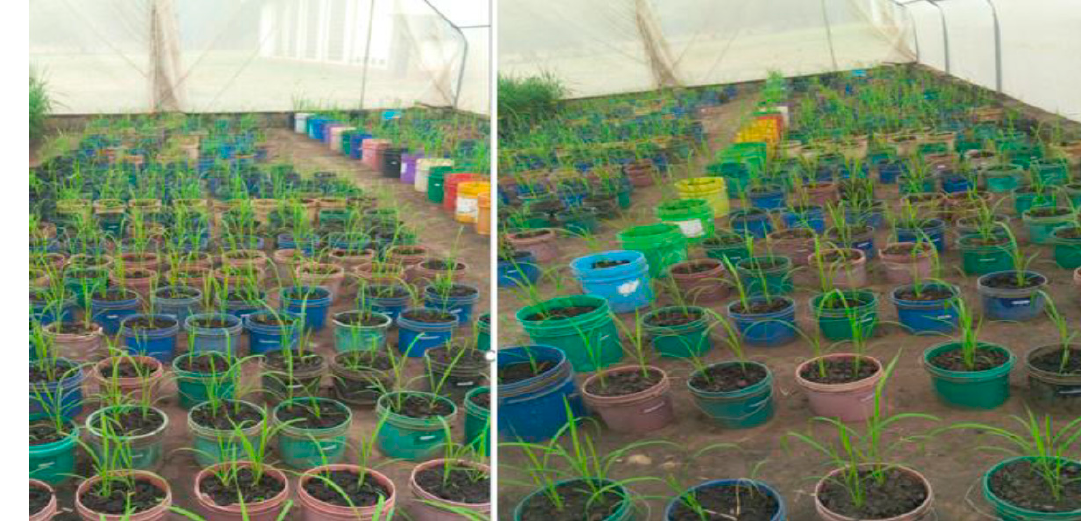
Figure 3. F1 plants established in plastic pots to produce F2 seeds. Table 2. Descriptions of the three sites used for evaluation of 45 crosses and 10